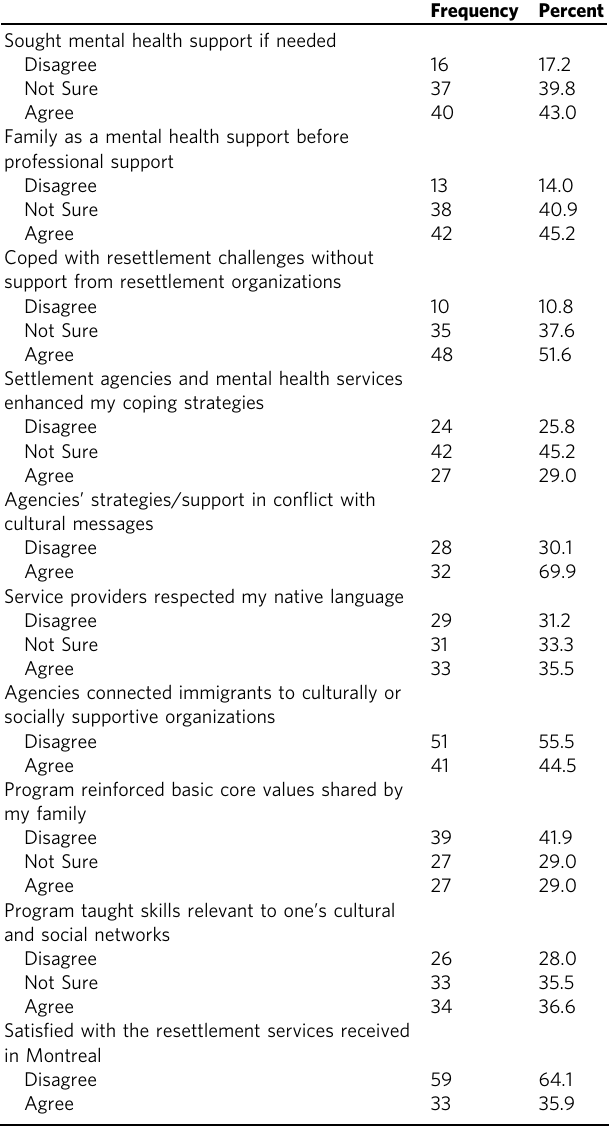
Table 2 Mental health and resettlement agencies programs ( N =